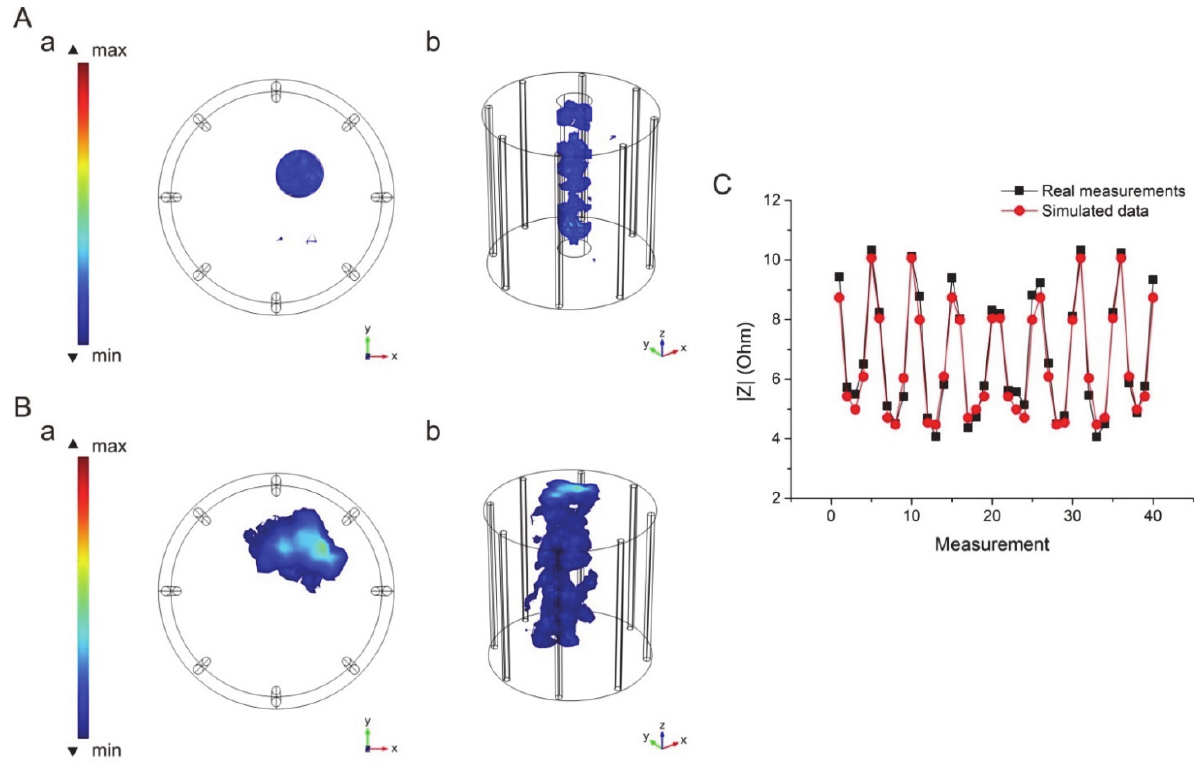
Fig. 4: t-EIT using the adjacent configuration (Fig. 2a) and the back-projection algorithm (Comsol Multiphysics) for image reconstruction of a cylindrical stainless steel object placed in the measurement chamber filled with electrolyte. (A) Computation of the FP (a, top view and b, isometric view). (B) Solution of the IP (a, top view and b, isometric view). The colour scales give a qualitative representation of the object impedance. (C) Match between the impedance measurements and the simulated data in the FP. The impedance modulus, |Z|, is reported for all the 40